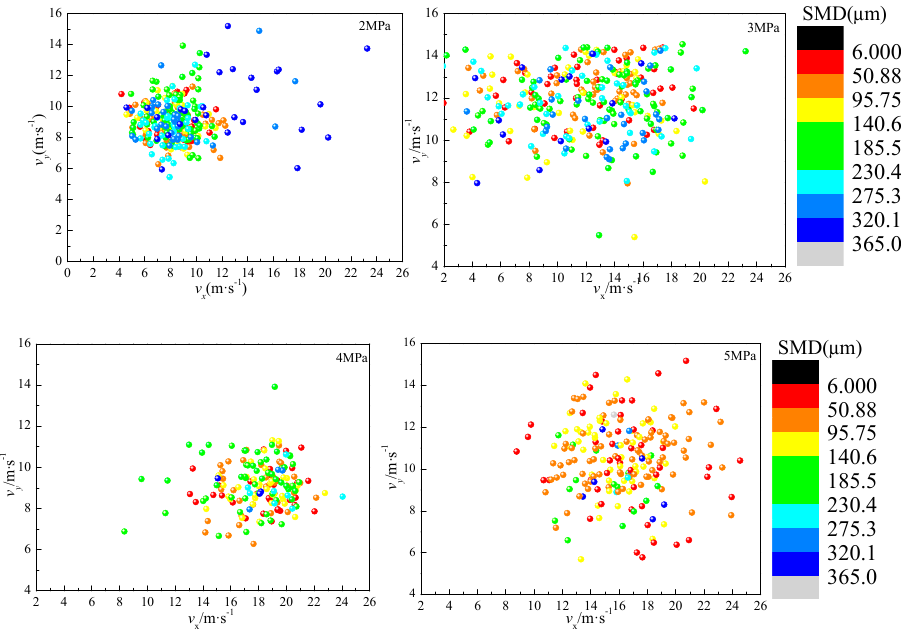
Figure 17. Joint particle size–velocity distribution changes with pressure (X = 200 mm, Y = 0 mm). According to the previous analysis, when X = 200 mm, the droplet is in the breakup